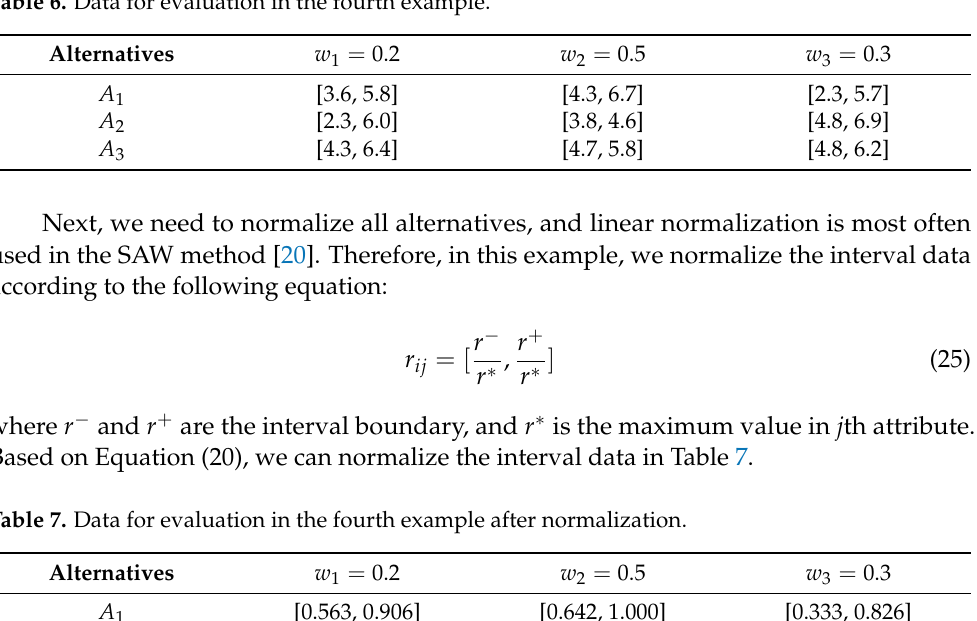
Table 6. Data for evaluation in the fourth example.